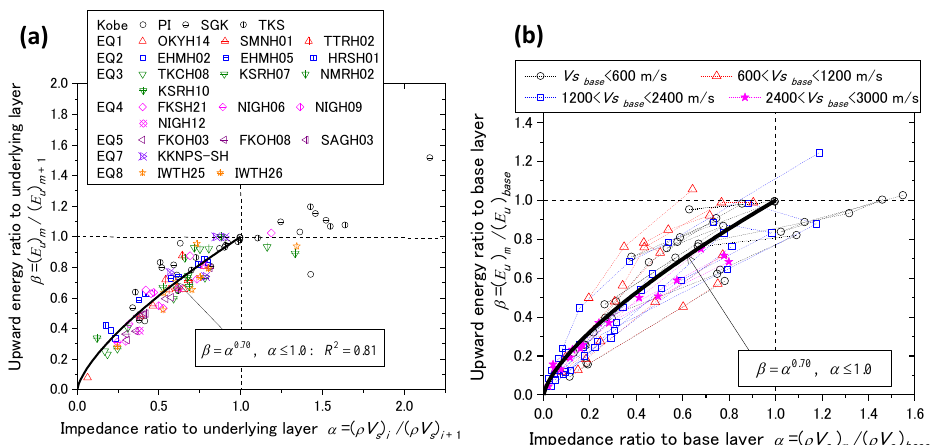
Figure 14. Upward energy ratios β versus corresponding impedance ratios α compared with empirical formula: between neighboring layers ( a ) and between a given layer and base layer ( b ).